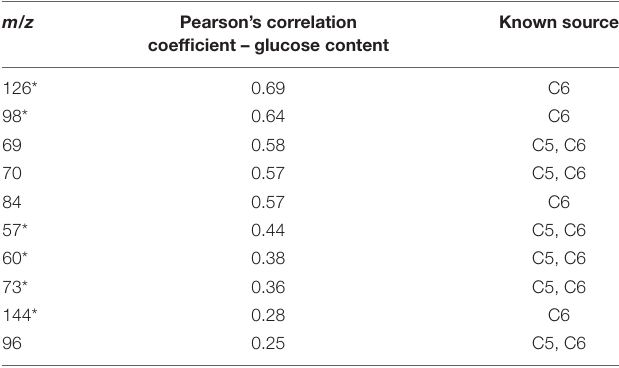
TABLE 1 | Pearson’s correlation coefficients (PCCs) for selected ions as they relate to glucose content in P. trichocarpa natural variant biomass samples. m/z Pearson’s correlation coefficient – glucose content